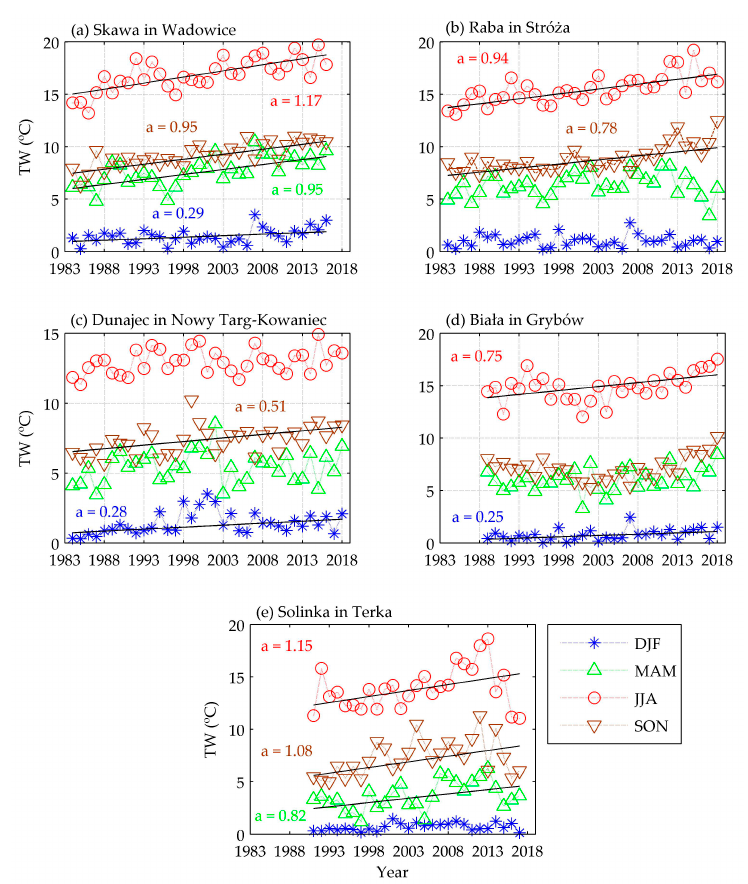
Figure 3. The course of seasonal water temperature and significant ( p < 0.05) trend intensity a (°C per decade) for the studied rivers: ( a ) the Skawa in Wadowice; ( b ) the Raba in Stró ż a; ( c ) the Dunajec in Nowy Targ-Kowaniec; ( d ) the Bia ł a in Grybów; ( e ) the Solinka in Terka.